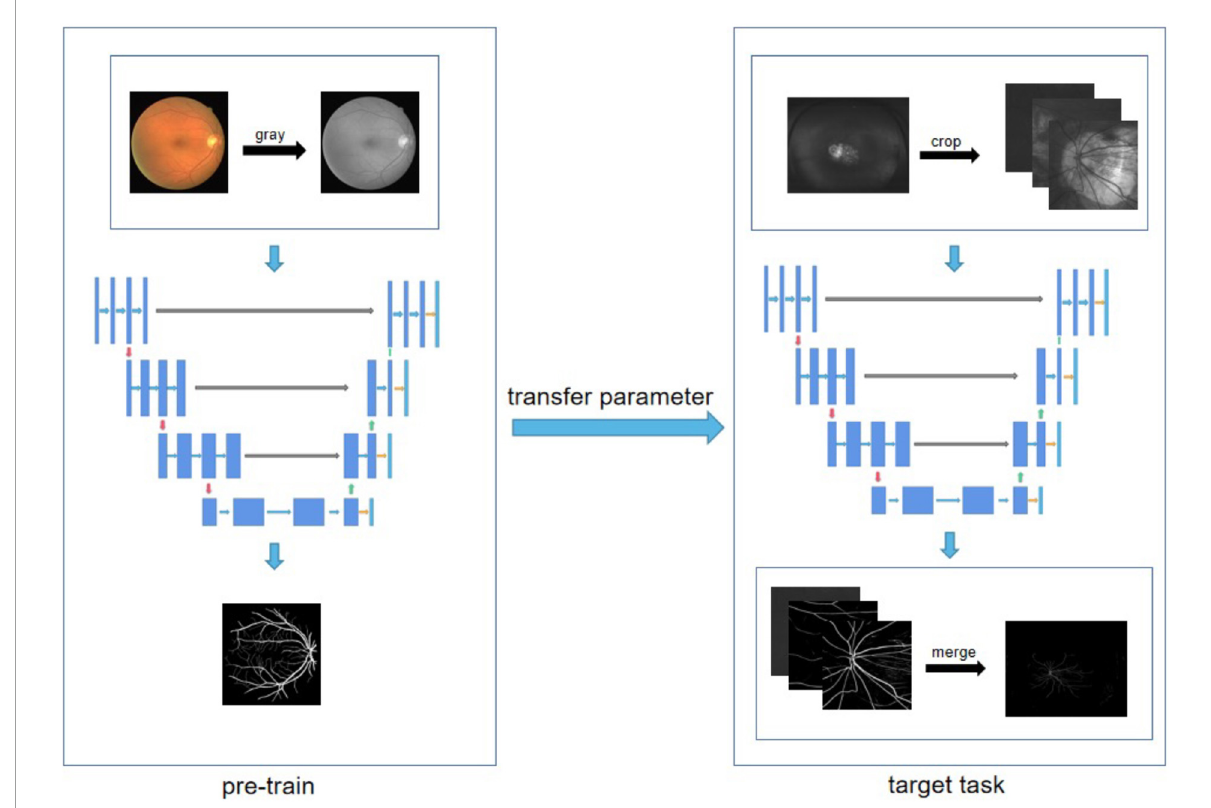
FIGURE1 The schematic diagram of the transfer learning technology used in this study.